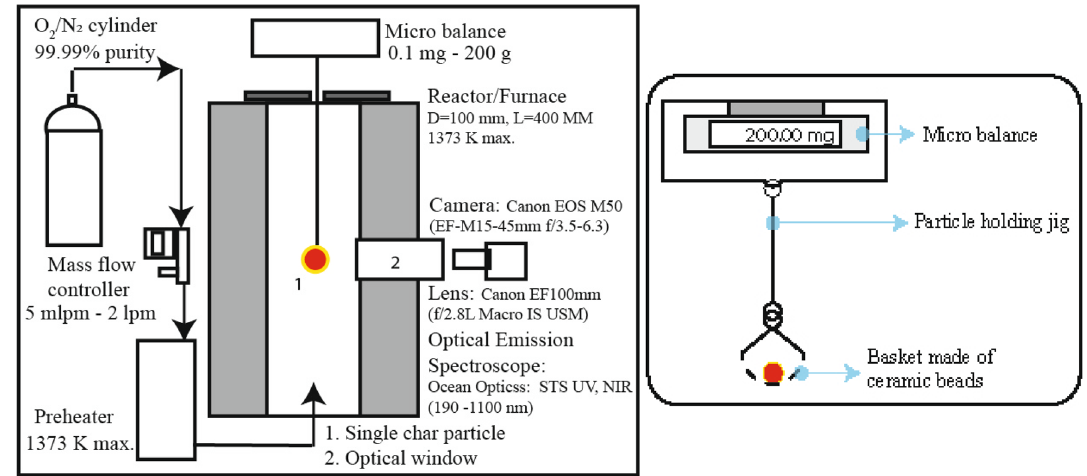
Figure 1. Single particle experimental setup and detailed illustration of particle holding